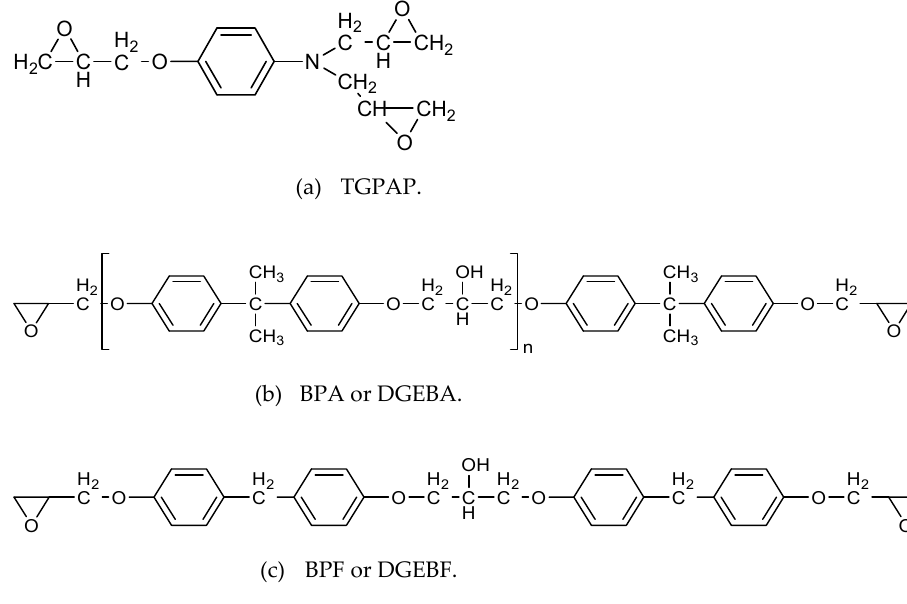
Figure 3. Chemical structure of ( a ) TGPAP, ( b ) BPA or DGEBAand ( c ) BPF or DGEBF. Table 1. Properties of the resins and hardener used in this study.